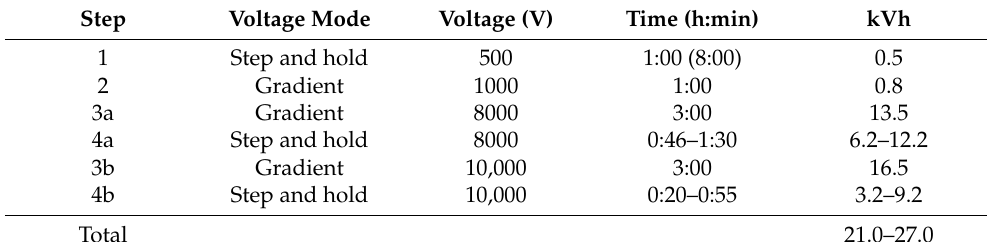
Table 5. Guideline for running the 18-well OFFGEL unit with pH gradient